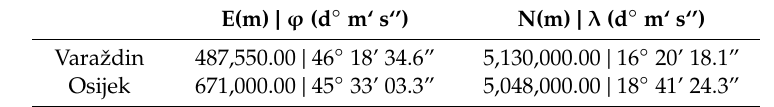
Table 3. The coordinates of the study areas (projection: EPSG 3765 | WGS84).